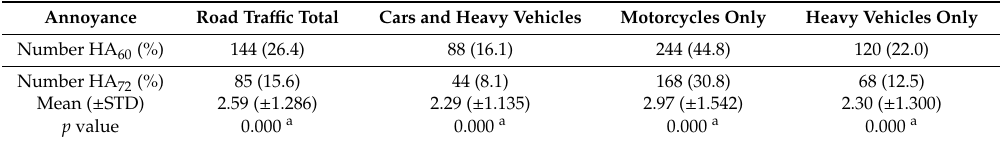
Table 4. Percentages of highly annoyed people, mean values, standard deviations and test